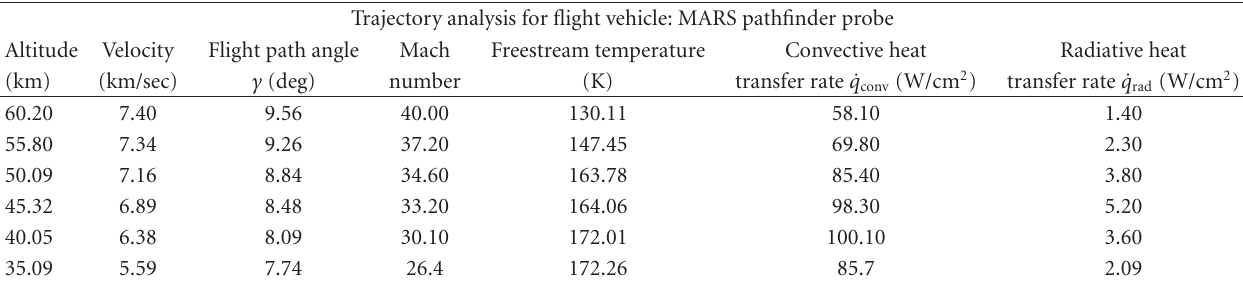
Table 4: Pathfinder flight trajectory data reconstructed by Sparta trajectory engine. Trajectory analysis for flight vehicle: MARS pathfinder